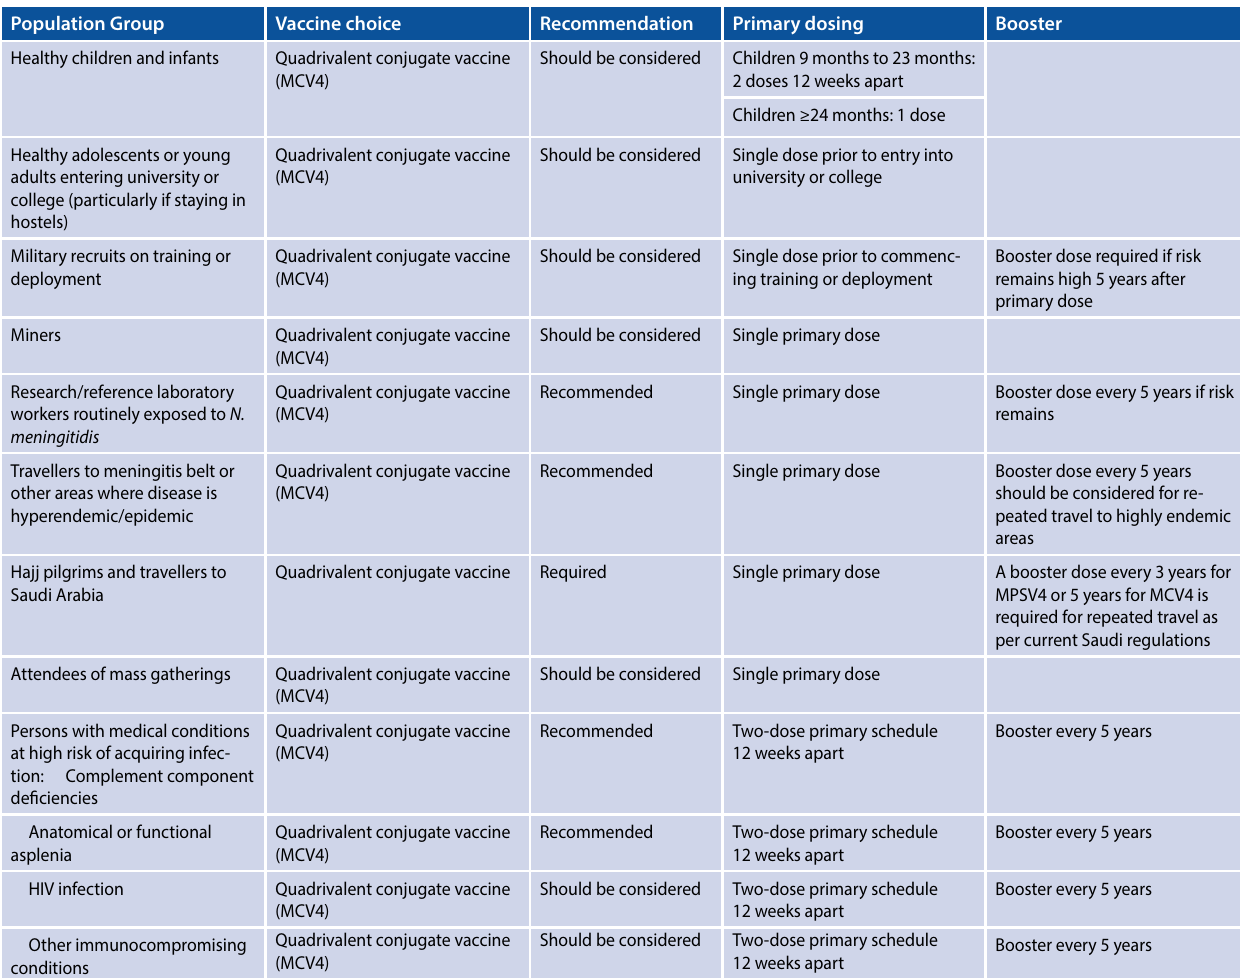
Table 1: Suggested recommendations of use of meningococcal vaccine in South Africa Population